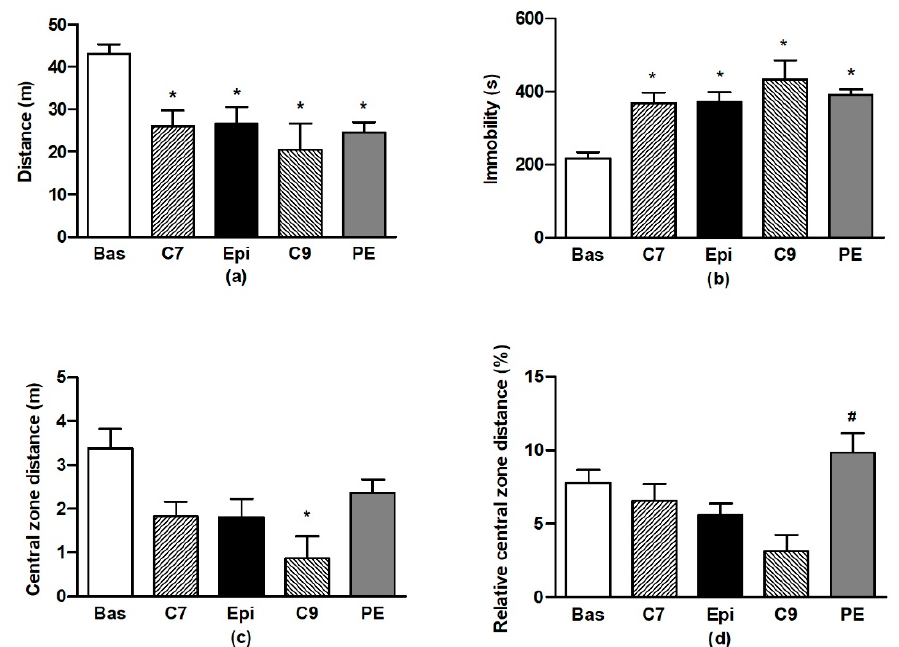
Figure 2. The effect of (–)-epicatechin on the behaviours of borderline hypertensive rats. Total distance travelled ( a ) and total immobility ( b ) in the open field; total distance ( c ) and relative distance ( d ) travelled in the central zone of the open field. The values represent the mean ± SEM. * p < 0.05 vs. the basal group value, # p < 0.05 vs. the C9 group. Abbreviations. C7: seven-week-old control group, C9: nine-week-old control group, Epi: (–)-epicatechin group, PE: (–)-epicatechin post-treatment group.